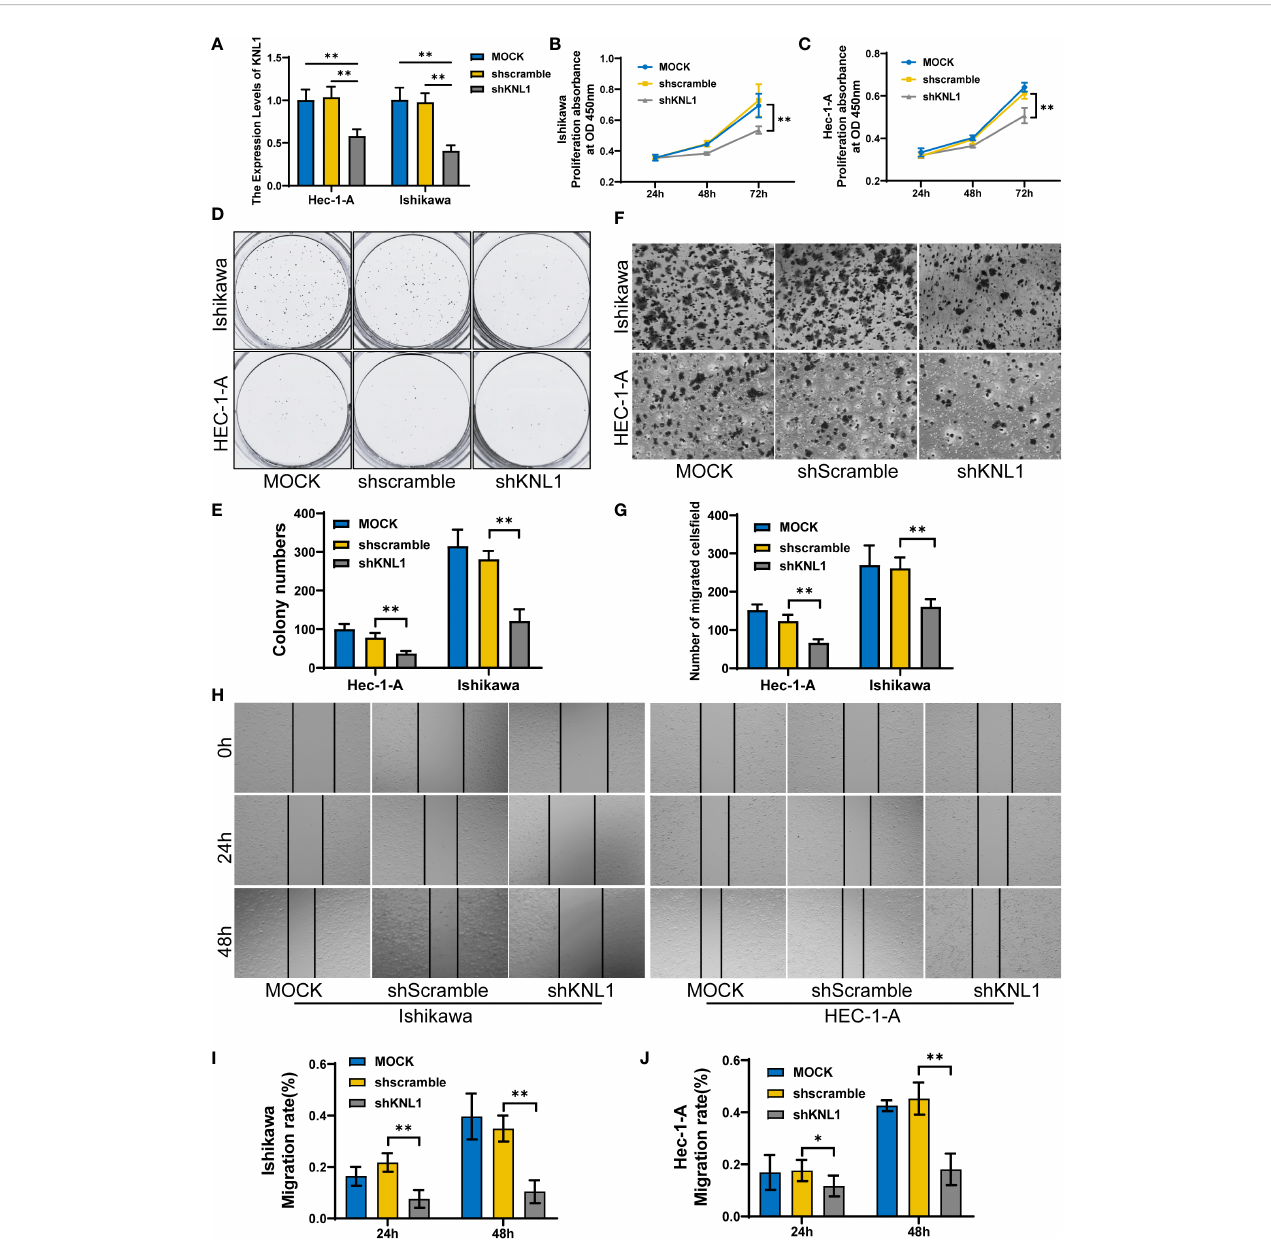
FIGURE 8 Effect of knockdown of KNL1 expression in UCEC cell lines on tumor cell proliferation, invasion and other phenotypes. (A) Ishikawa and Hec-1-A cells were transfected with shKNL1, and the level of KNL1 was evaluated by qRT − PCR. (B, C) The proliferation of Ishikawa and Hec-1-A cells was examined by CCK-8 (D, E) and colony-formation assays. (F, G) The migration of Ishikawa and Hec-1-A cells was examined by Transwell assays. (H – J) The metastatic capacity of Ishikawa and Hec-1-A cells was examined by wound-healing assays. Signi fi cance identi fi er: p ≥ 0.05; *, p< 0.05; **,